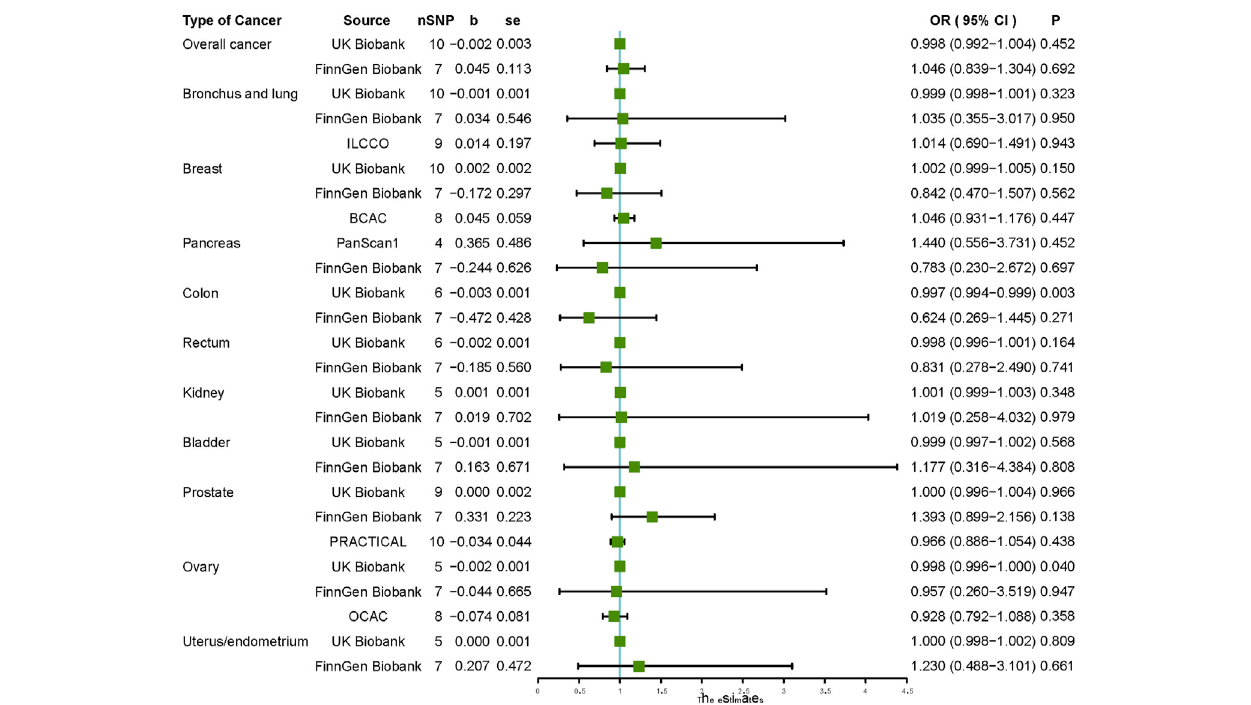
FIGURE 2 | Causal effect estimates of vitamin C on cancer outcomes. SNP, single-nucleotide polymorphism; OR, odds ratio; CI, con fi dence interval; UKBB, UKn Biobank; ILCCO, International Lung Cancer Consortium; BCAC, Breast Cancer Association Consortium; PanScan1, Pancreatic Cancer Cohort Consortium GWAS; PRACTICAL, Prostate Cancer Association group To Investigate Cancer-Associated Alterations in the Genome; OCAC, Ovarian Cancer Association Consortium.